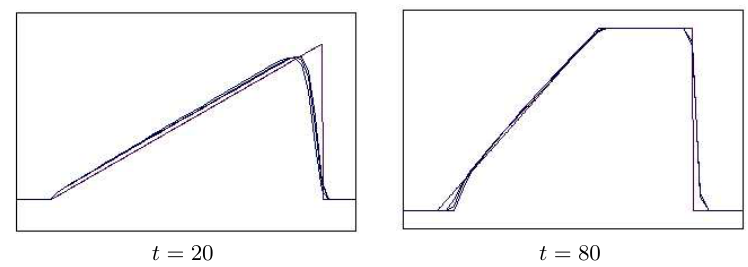
Figure 9. Numerical solution for the jumping advection method for 4 initial data ( (cid:13) = 0 : 5; 0 : 9 )